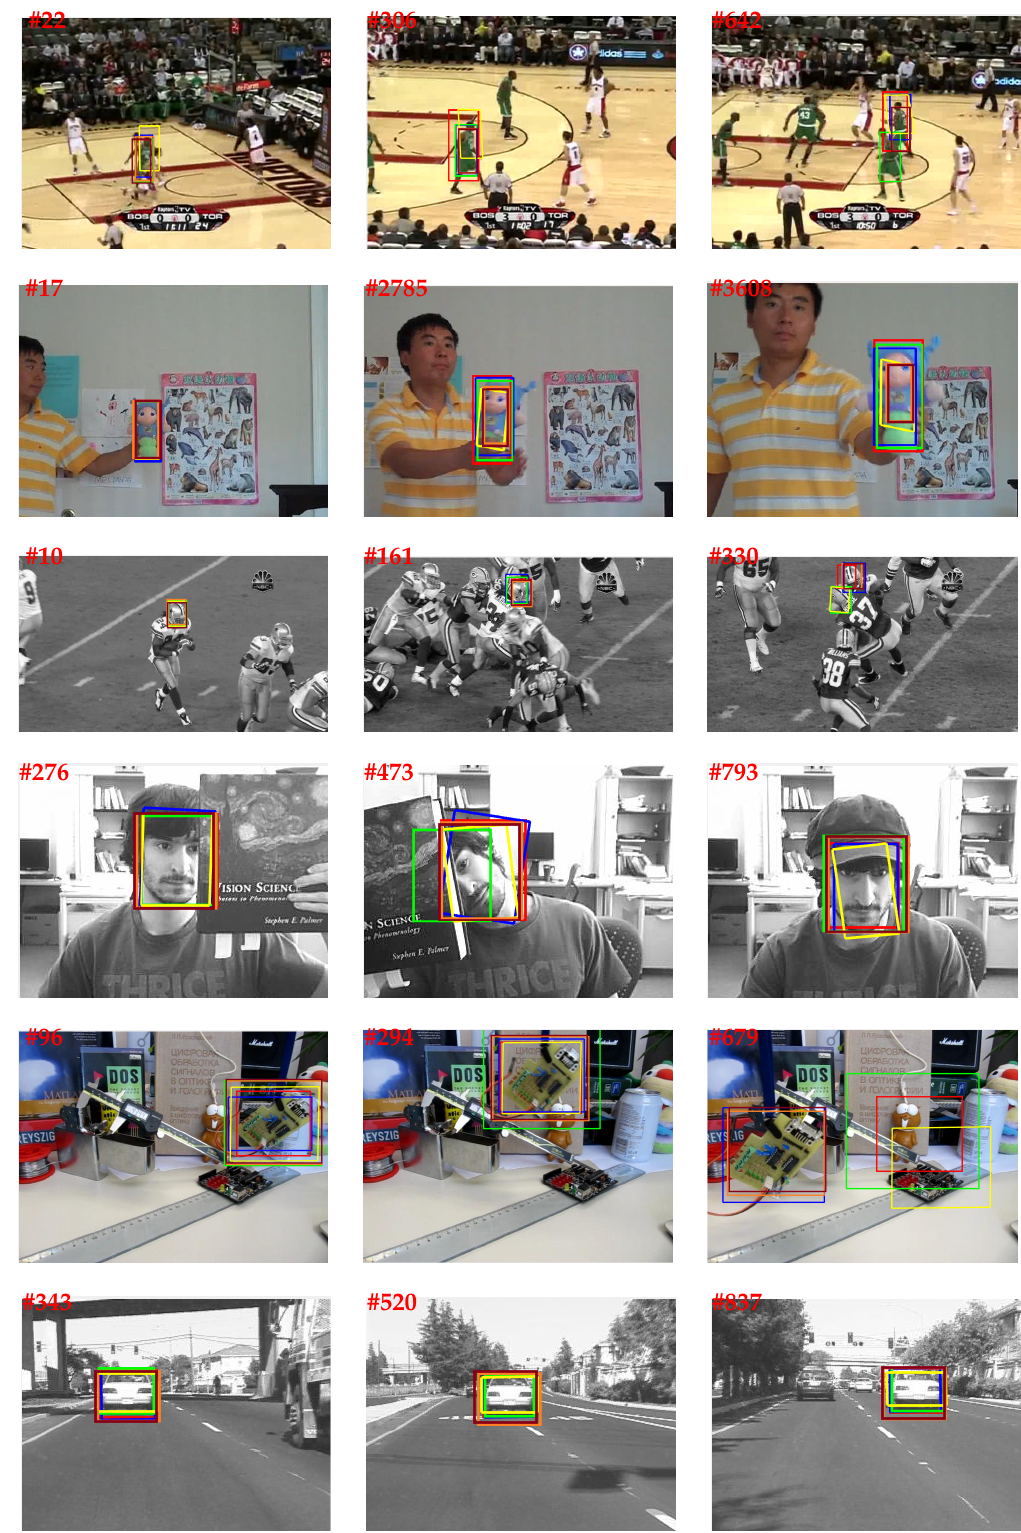
Figure 6. Comparison of the tracking results of the proposed STLDF and top five state-of-the-art trackers on basketball , doll , football , faceOcc2 , board , and car2 image sequences. Frame indices are shown at the top left corner of each representative frame. Results are best viewed on high-resolution displays. ( — CF2, — HDT, — RSST_Deep, — Staple, — SRDCF, —